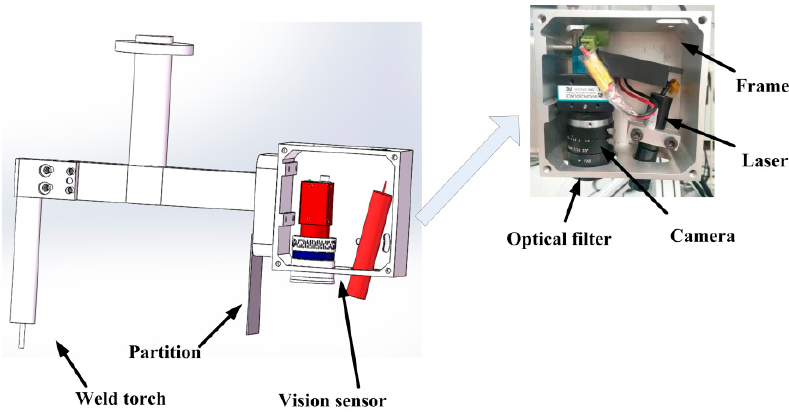
Figure 1. ( Left ) weld torch and visual sensor model; ( Right ) visual sensor.